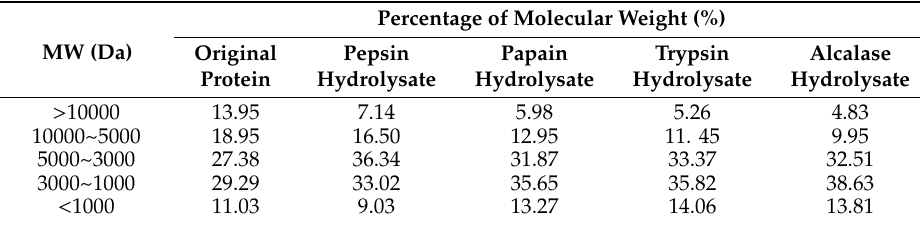
Table 1. Molecular weight